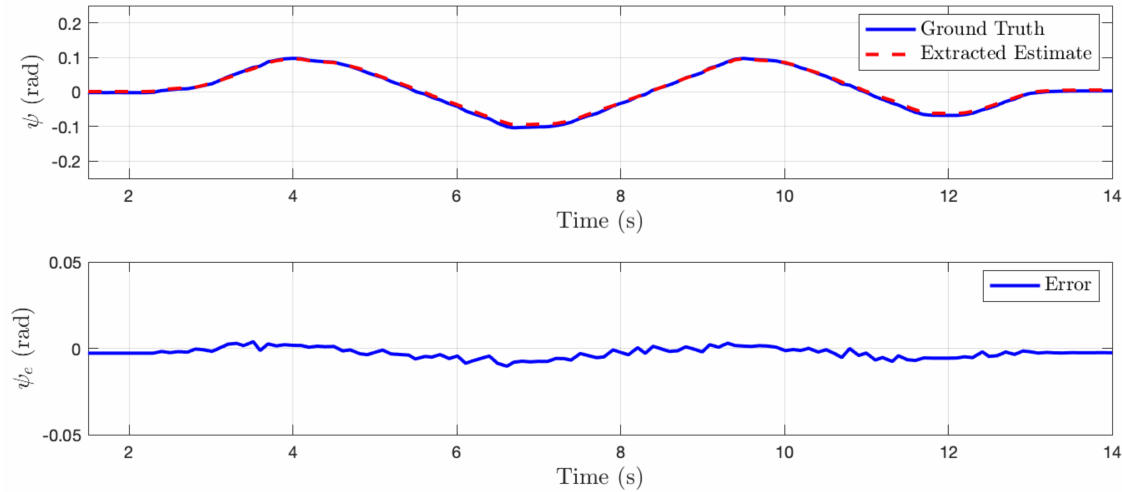
Figure 8. ( top ) Comparison of estimated heading relative to cylinder centerline to ground truth as system yaws back and forth. ( bottom ) State error plotted as a function of